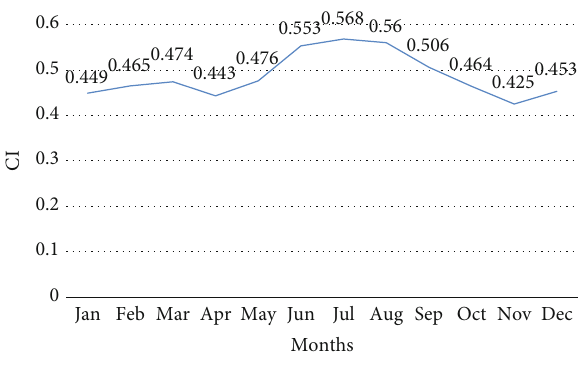
Figure 31: Monthly clearness index (CI) for Burundi.